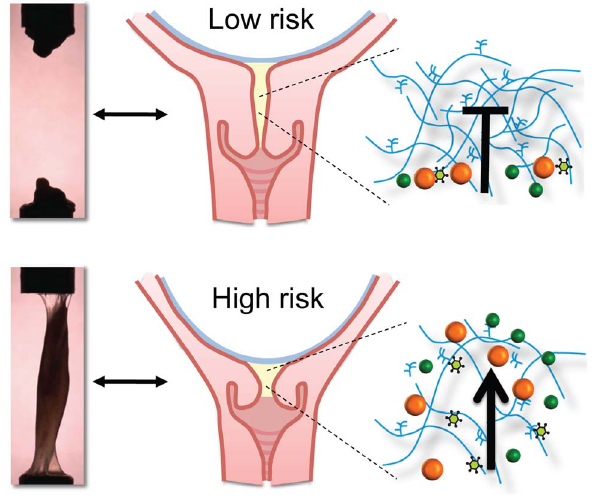
Figure 5. Example scanning electron microscopy images. Cervical mucus samples from low-risk and high-risk patients were fixed and dehydrated for examination by electron microscopy. Scale bar: 200 nm.